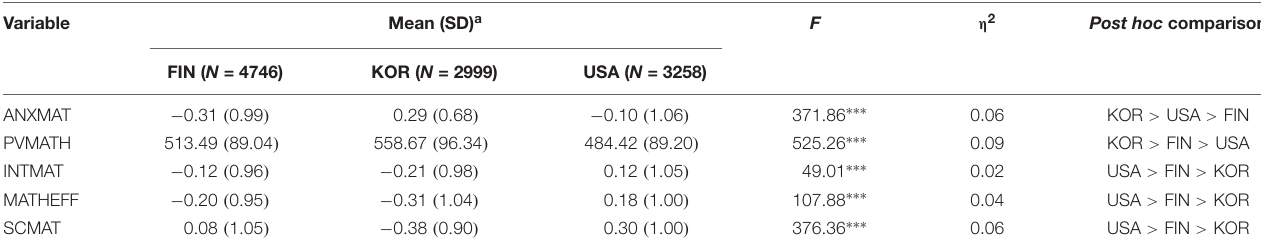
TABLE 2 | Means, SDs, and post hoc comparisons of mathematics anxiety and learning outcomes across the three samples.